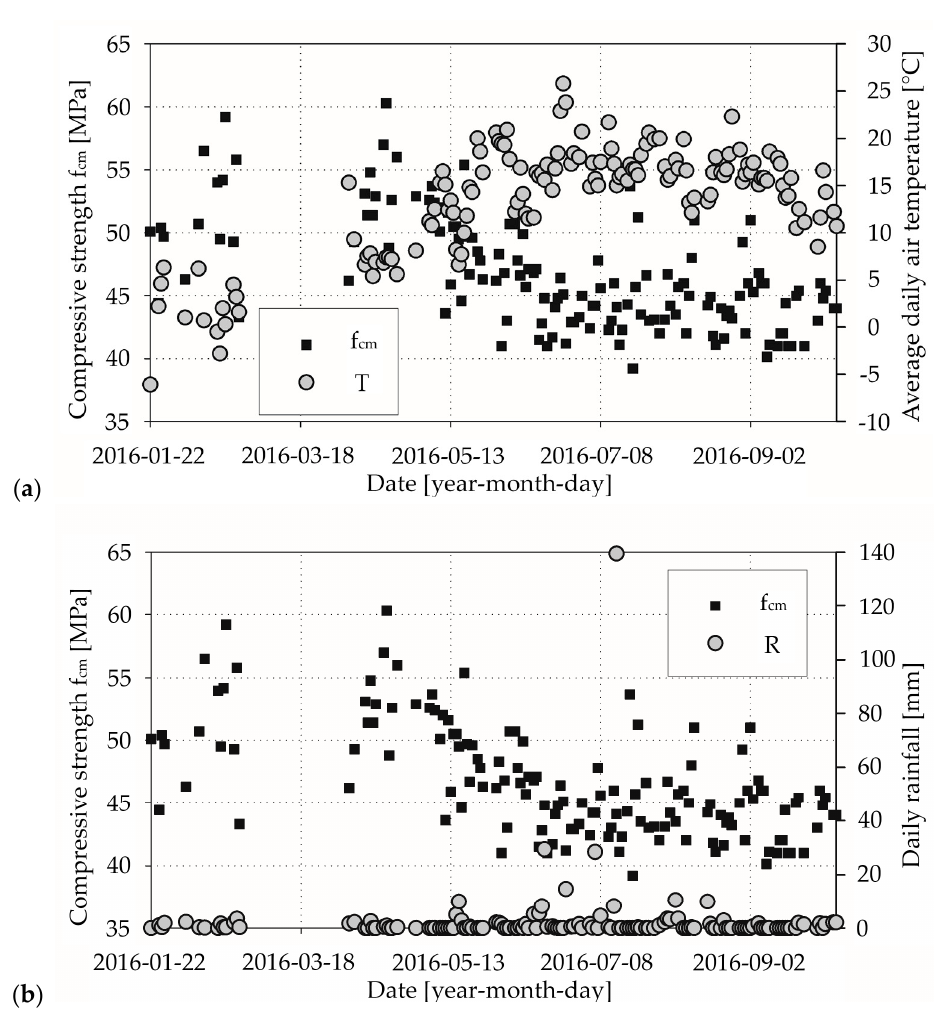
Figure 2. Laboratory test results for concrete mix CM_A type: ( a ) compressive strength and corresponding average daily air temperatures; ( b ) compressive strength and corresponding daily rainfall.